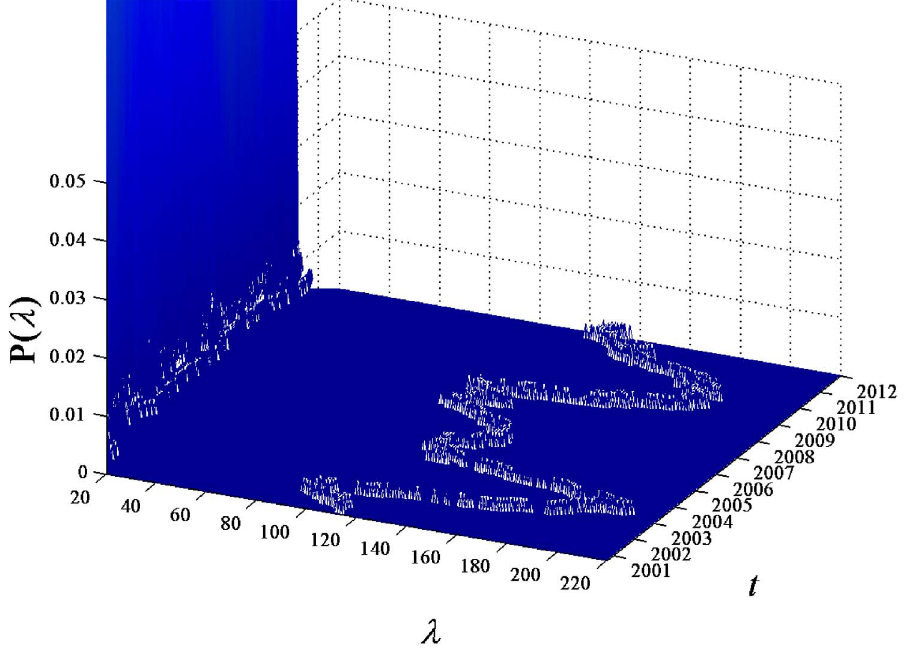
Figure 4. Enlarged eigenvalue distribution. Partial enlarged drawing of eigenvalue distribution for l w 20 .